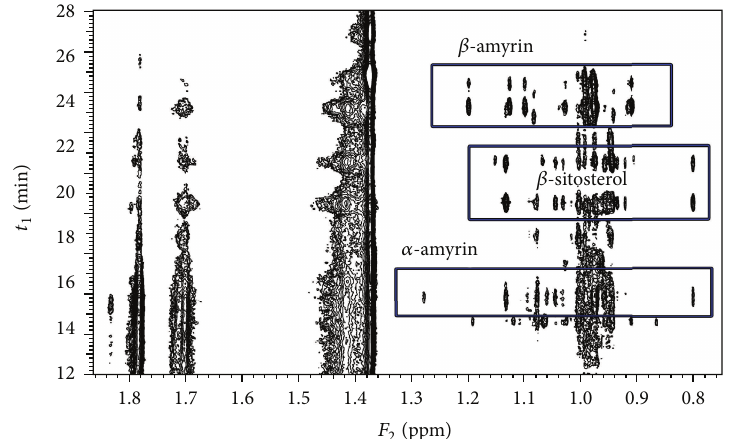
Figure 7: HPLC-NMR measurement of the conjugated phytosterol fraction extracted from the sea buckthorn leaves; isocratic method (CDCl 3 :acetonitrile, 50 :50). Table 2: Composition of the fraction of free phytosterols in the sea buckthorn leaves determined by HPLC-NMR. Compound Comparative content a Overall content in the leave extract b Retention time (min) c Erythrodiol 3% Uvaol Oleanolic aldehyde Unknown